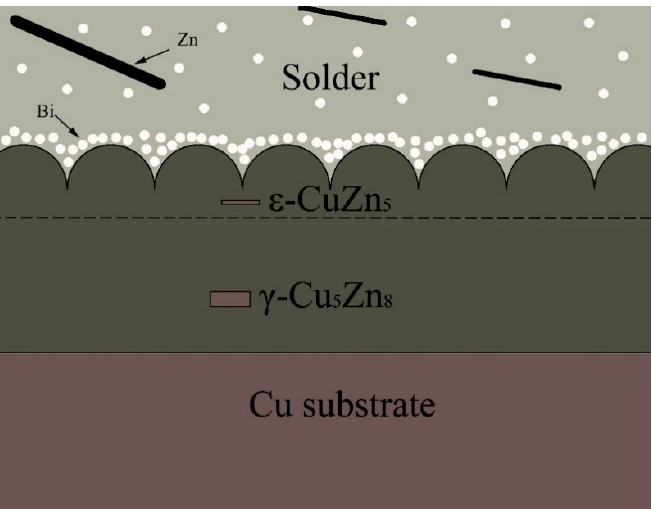
Figure 14. Schematic diagram of cross-sections of IMC layer formed in Sn-9Zn-xBi/Cu solder joint. Suganuma et al. [23] also conducted related research and reported the existence of three Cu-Zn IMC layers of Sn-9Zn and Cu joints. They are γ -Cu 5 Zn 8 phase, which is close to the solder, and β -CuZn, which is in the middle of the IMC layer, and a thin and unidentified layer close to the Cu substrate. Mayappan et al. [24] reported an IMC layer consisting of ε -CuZn phase and γ -Cu 5 Zn 8 phase. Some studies reported the IMC layer composed of γ -Cu 5 Zn 8 phase [22,25]. The results of these studies are not the same, but they are all Cu-Zn compounds; this is because the composition of the Sn-Zn-based alloy